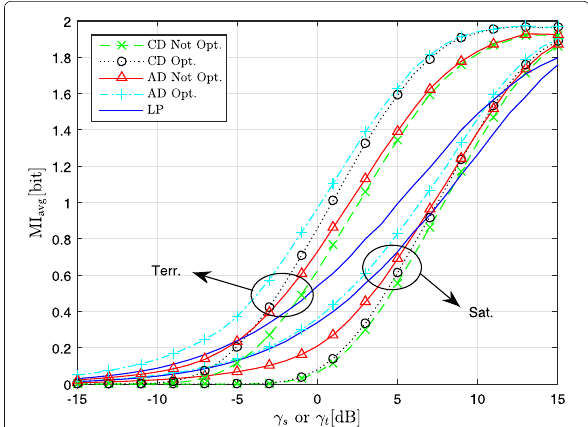
Fig. 6 Performance of CD, AD and LP for 4-PAM on terrestrial and satellite channel